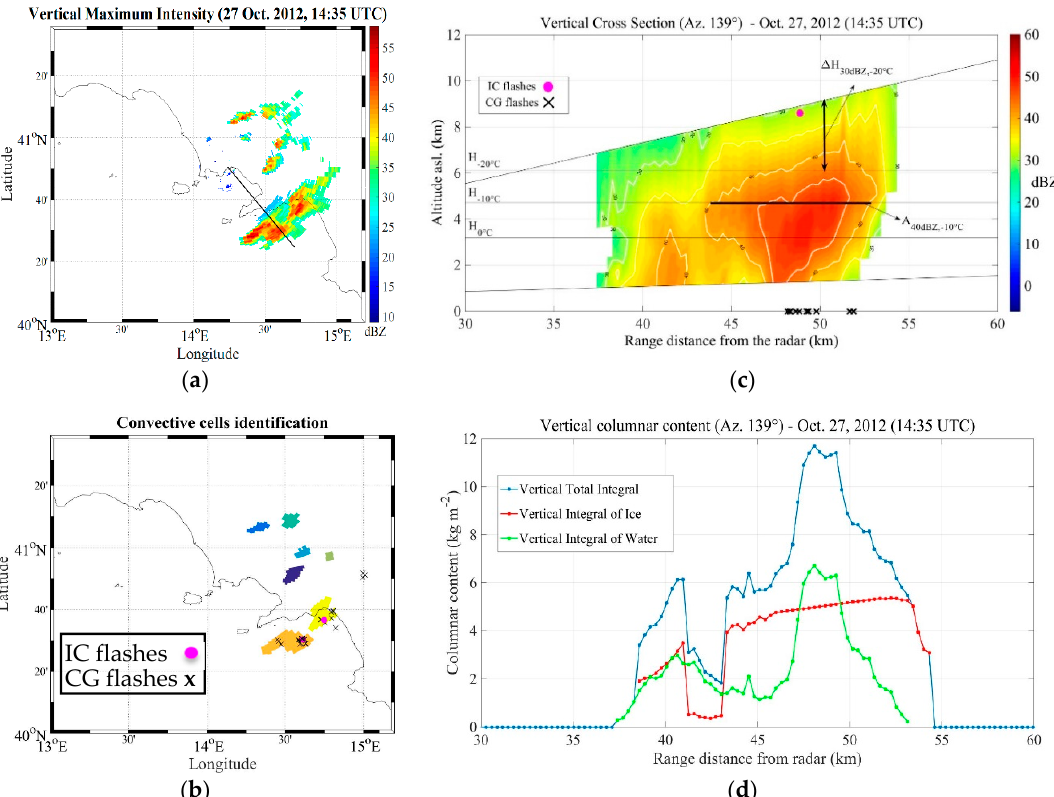
Figure 3. Example of rain cells observed by the WR-10X radar on 27 October 2012 at 14:35 UTC. Panel ( a ) VMI of radar reflectivity factor. Panel ( b ) output of the rain cell identification procedure, where the area occupied by each rain cell is color coded. The distribution of strokes registered by the LINET network in the two minutes coincident with the radar acquisition, namely between 14:35 and 14:36 UTC, is overimposed to rain cell patterns. Panel ( c ) Range Height Indicator (RHI) referred to the azimuth at 139°, shown in the panel ( a ) by the black radial line. In this panel, some radar-based stroke predictors, such as ∆ H 30dBZ, − 20°C , A 40dBZ, − 10°C , and the environmental variables H 0°C , H − 10°C , and H − 20°C are shown. The cloud-to-ground (CG) and intra-cloud (IC) strokes are also highlighted as black crosses and magenta filled-in circles, respectively. The panel ( d ) shows VII , VIW , and VTI for the same rain cell in the upper right panel. Table 3. Key-parameter settings of Storm Cell Identification and Tracking (SCIT) algorithm. A detailed description of the listed parameters can be found in [60].